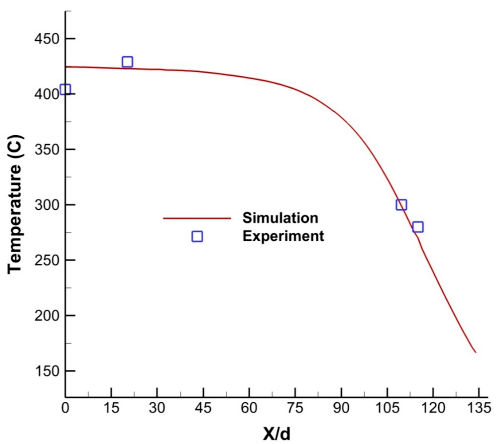
Figure 12. Comparison of temperature distribution on the back side of the steel plate between the numerical simulation and experimental result in steady state.